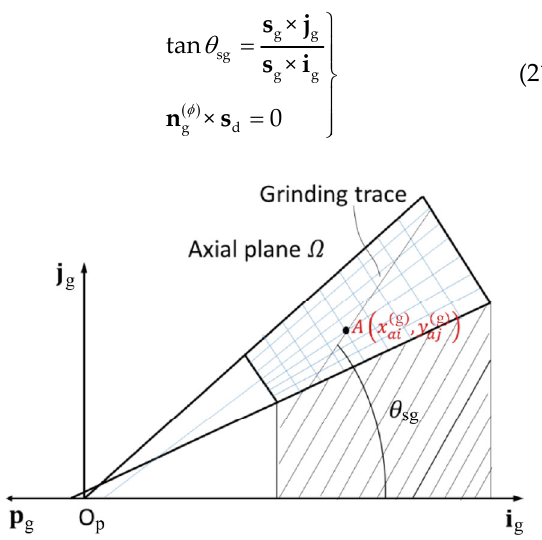
Fig. 5 Gear flank and roughness direction in axial plane Ω